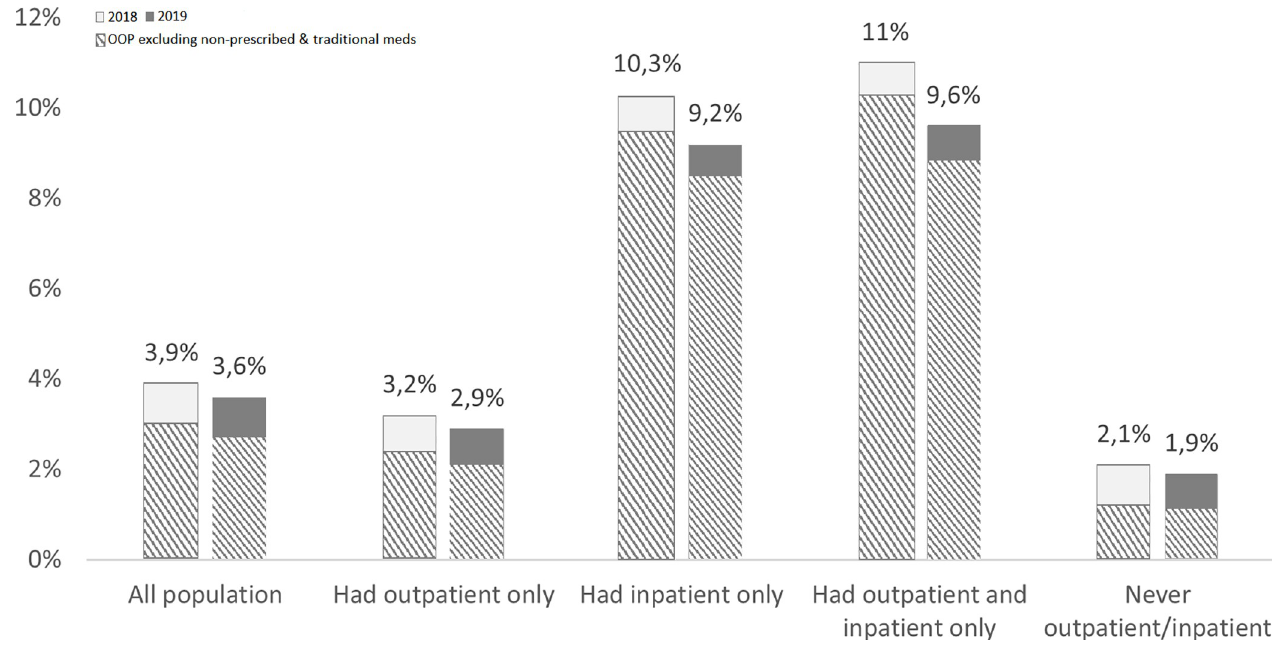
Fig 1. Share of OOP payments out of total non-food expenditure. Source: Own calculation using Susenas 2018 and 2019.